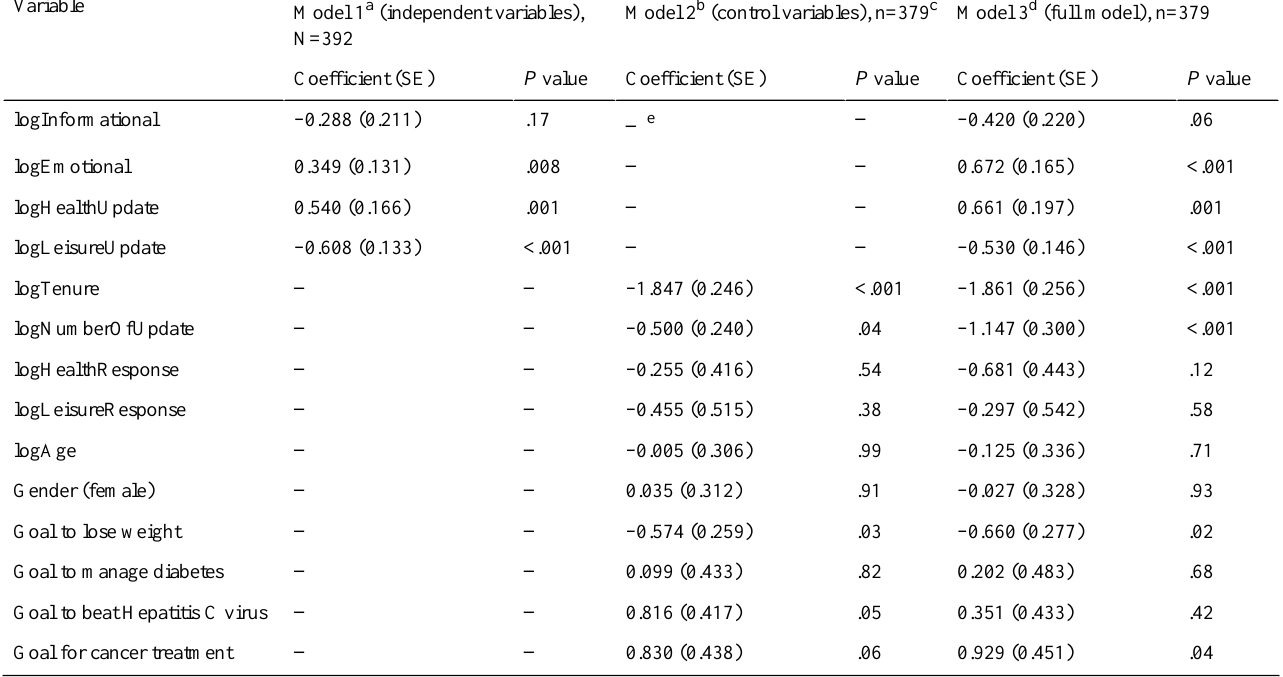
Table 1. Estimates of the Cox proportional hazard model on the rate to goal attainment occurrence.